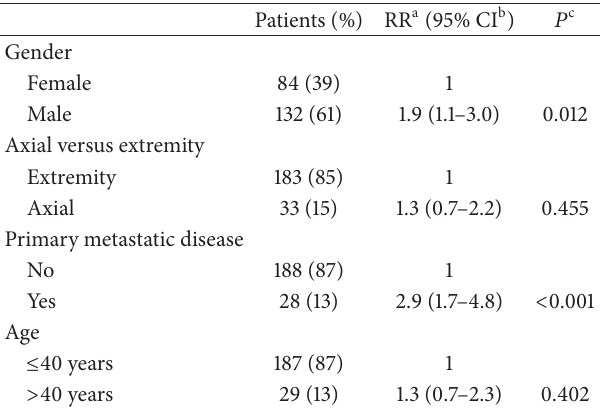
Table 6: Univariate Cox-regression analysis of overall survival among all adequate treated high-grade osteosarcoma